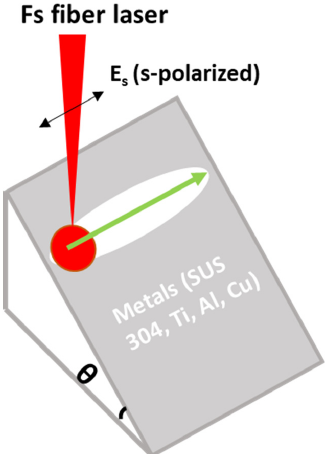
Figure 1. Schematic of fabricating the low spatial frequency LIPSS (LSFL) on different